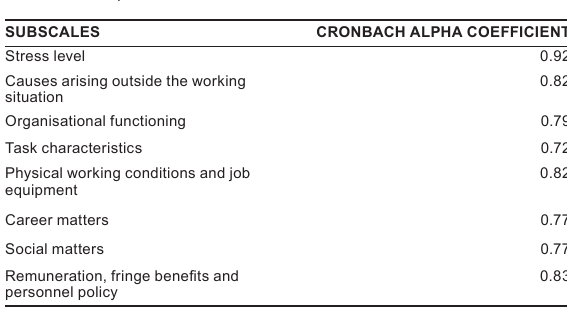
TABLE 1 Percentage of variance explained by the factors extracted from the subscales of the Experience of Work and Life Circumstances Questionnaire